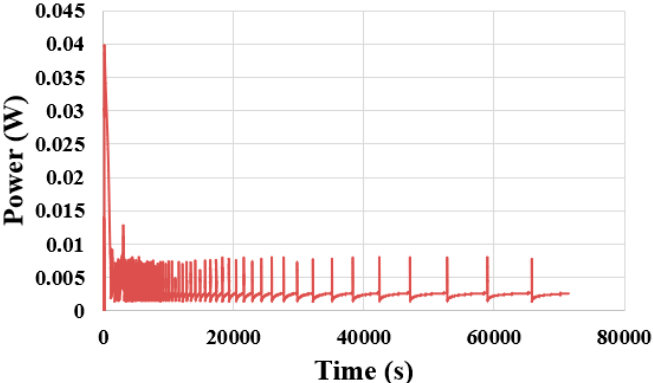
Figure 13. Power output during the proton battery discharge.